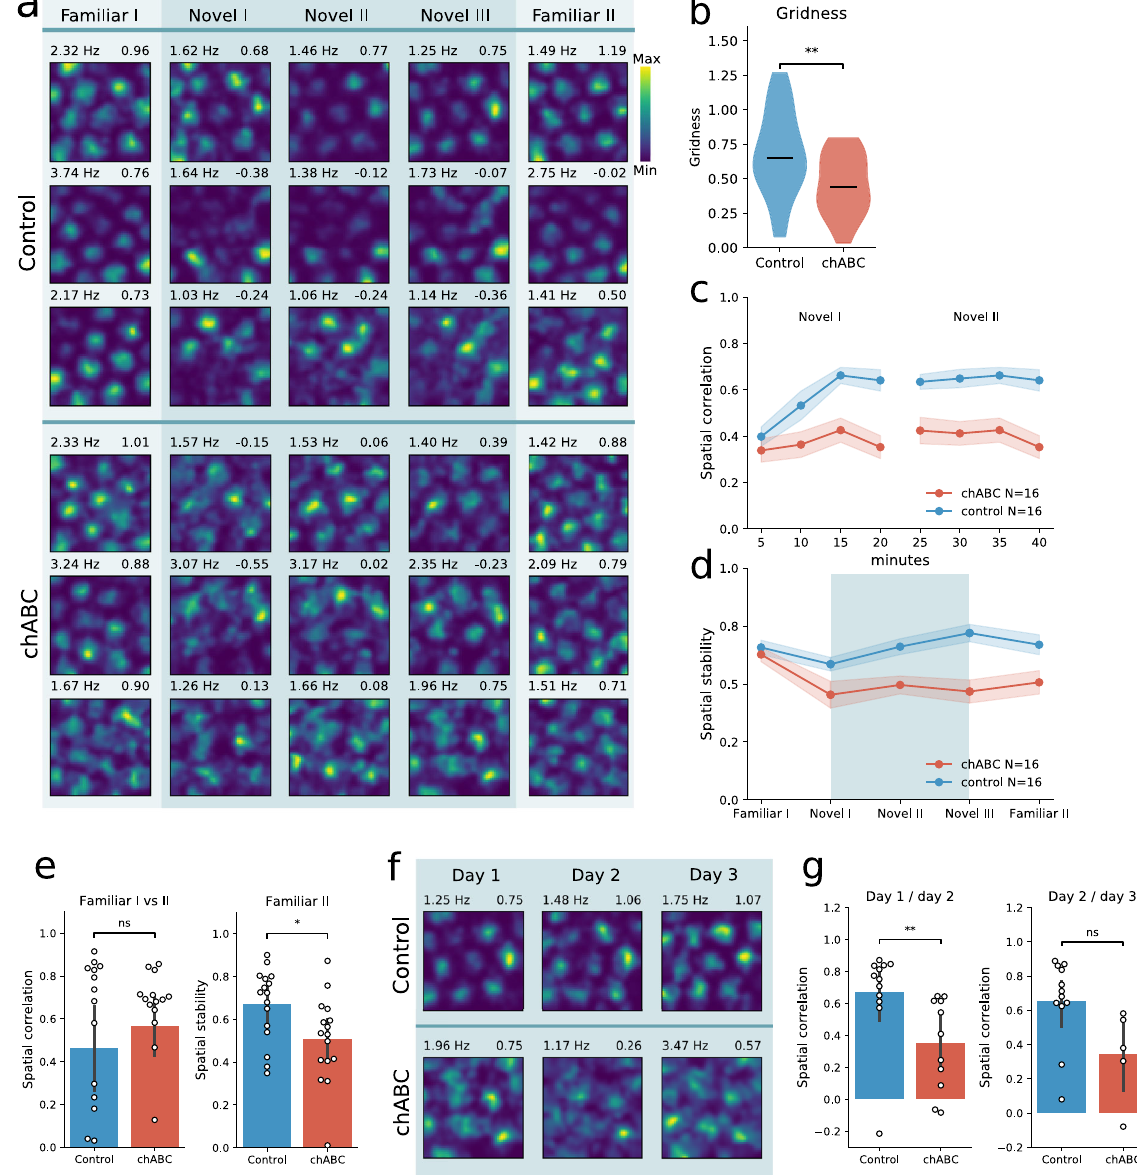
Fig. 3 Reduced grid cell stability in novel environment. a Rate maps of fi ve consecutive 20min recording sessions from six individual grid cells, recorded in control animals (top) and chABC animals (bottom) during a novel environment experiment. Color code indicates spike rate. Rows correspond to individual units and columns correspond to environment. Maximum spike rate (left) and gridness (right) is denoted above each rate map. b Gridness score is reduced in the novel environment in animals treated with chABC (median ( n ); Control 0.65 (35); chABC 0.44 (24); p = 0.004, U = 606, Mann – Whitney U test (two sided)). c Spatial correlation measured for blocks of 5-min recordings in the novel environment sessions I and II, measured against the novel environment session III. Only units reaching gridness threshold in Familiar I and that could be identi fi ed in all fi ve recording sessions were included. Animals treated with chABC showed reduced spatial correlations in the novel environment (mean±s.e.m.; Control 0.59±0.03; chABC 0.37± 0.04; main effect of group: F (1, 30) = 14.22, p = 0.0007; interaction: F (7, 210) = 4.905, p <0.0001, Control n = 16; chABC n = 16, two-way repeated measures ANOVA with group and time as factors). Points indicate mean; shaded area represents s.e.m. d Spatial stability of the same units as in c , measured by the within-trial spatial correlation of grid cell rate maps (0 – 10 min correlated with 10 – 20min). Points indicate mean; shaded area represents s.e.m. Spatial stability decreased from Familiar I to Novel I in the chABC- treated group, but not in the control group (median; Control Familiar I 0.67; Control Novel I 0.54, p = 0.086; chABC Familiar I 0.65; chABC Novel I 0.45, p = 0.015, Mann – Whitney U test (two sided)). e Spatial stability was similar for both groups in Familiar I (median; Control 0.67; chABC 0.65, p = 0.629). After exploring the novel environment, chABC animals showed reduced spatial stability upon returning to the familiar environment (Familiar II) (median; Control 0.72; chABC 0.53, p = 0.018, Control n = 16; chABC n = 16, Mann – Whitney U test). f Rate maps of two grid cells when introduced to the novel environment for three consecutive days. g Spatial correlation of grid cells from chABC-treated animals was decreased in the novel environment when comparing day 1 with day 2 (median; Control 0.76, n = 12; chABC 0.41, n = 11, p = 0.004, Mann – Whitney U test (two sided)). Rate map from the third novel session (Novel III) on the fi rst day was used for correlations with day 2. n.s. = not signi fi cant, * p <0.05, ** p <0.01. Source data are provided as a Source Data fi le.